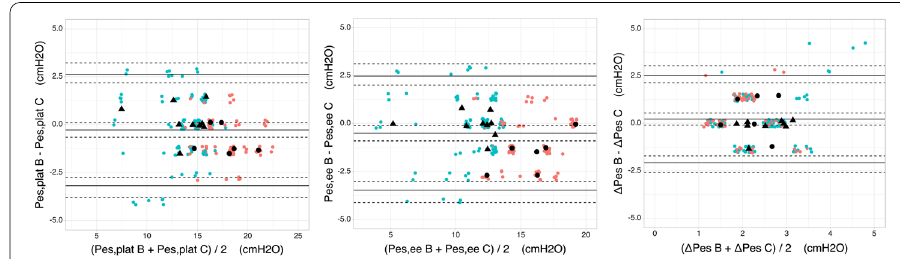
Fig. 3 Bland–Altman analyses in obese and non-obese patients under controlled mode. The difference between the plateau (left), end-expiratory (middle) and delta (right) esophageal pressures measured by the air-filled catheter and the balloon catheter in volume-controlled mode are plotted against the mean of the two measurements. Solid lines represent the mean differences and the limits of agreement. Dashed lines represent their respective 95% confidence interval. The colored circles represent single measurements ( n 12 = for each patient), with non-obese patients ( n 9) in green and obese ones ( n 6) in red. Black triangles and = = circles represent the medians of all measurements in non-obese and obese patients,